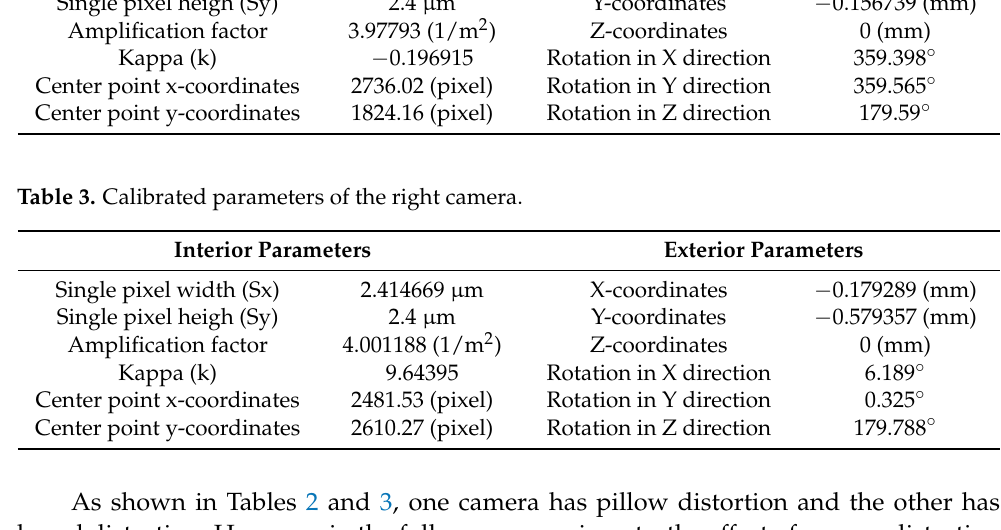
( b ) Figure 12. The subpixel coordinates of the images captured by camera. ( a ) The image captured by the left camera. ( b ) The image captured by the right camera. ( a ) ( b ) Figure 13. The fitting line of subpixel coordinates of the images captured by camera. ( a ) The image captured by the left camera. ( b ) The image captured by the right camera. As shown in Figure 14, S1 and S2 are the line segments of left and right fitted image edges, respectively. In real applications, because S1 and S2 cannot be guaranteed to be